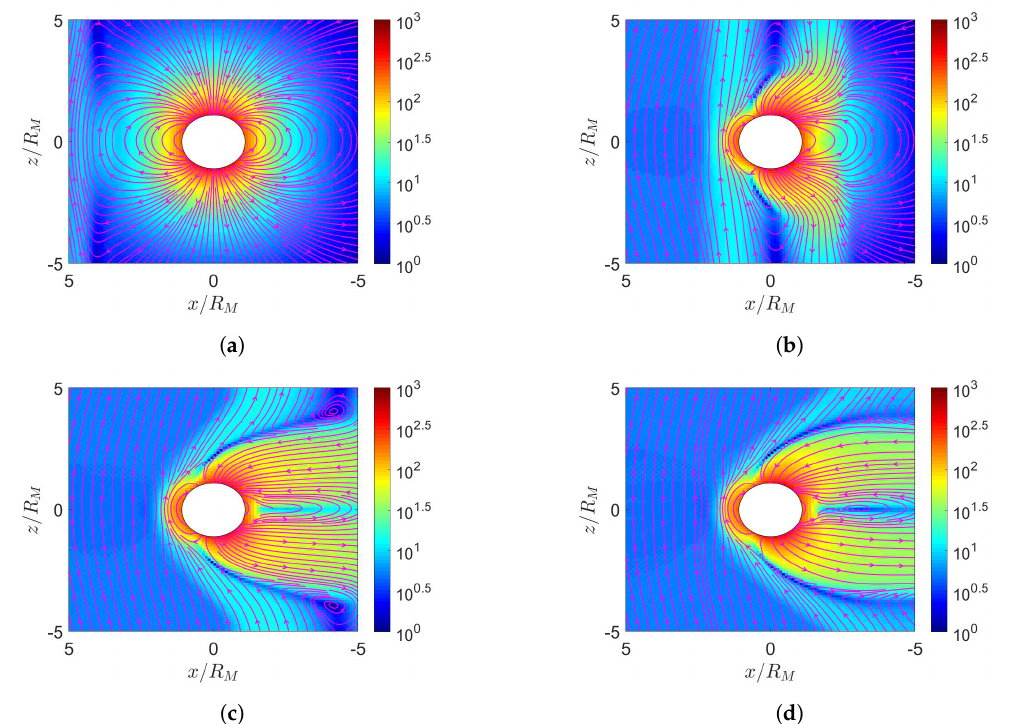
Figure 7. Time evolution of Mercury’s magnetic-field distribution under northward IMF. ( a ) t = 12.8 s, ( b ) t = 51.5 s, ( c ) t = 90.0 s, ( d ) t = 128.8